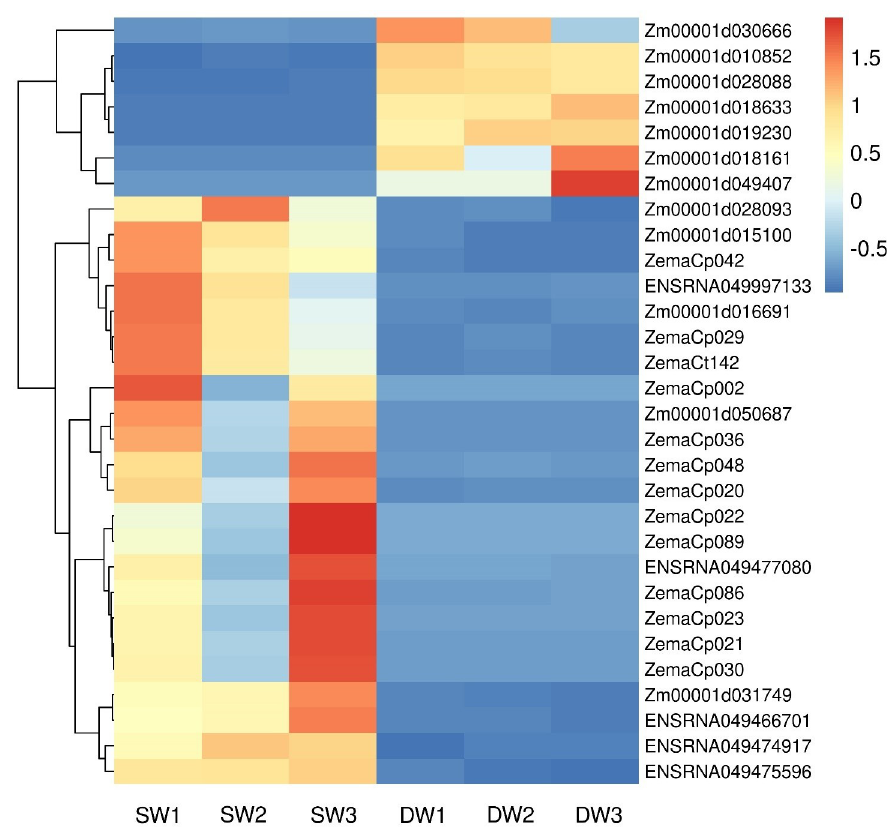
Fig 2. Clustering map of differential genes in maize leaves. SW refers to stable soil moisture content treatment, DW refers to alternately dry and wet treatment, and the number after that indicates the sample number. The abscissa is the sample, the ordinate is the differentially expressed genes screened out, and different colors indicate different gene expression levels, red indicates highly expressed genes, and blue indicates low expressed genes.